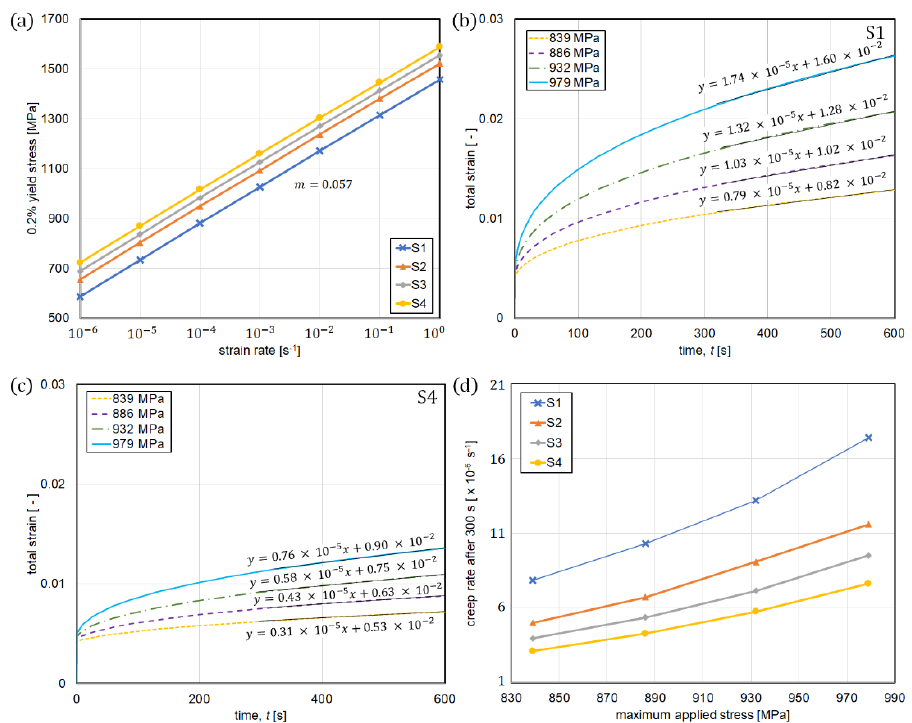
Figure 2. Strain rate sensitivity and creep responses for the superalloy. ( a ) yield stress under dif- ferent strain rates; creep strain accumulations of ( b ) S1 and ( c ) S4; ( d ) creep rate after 300 s.